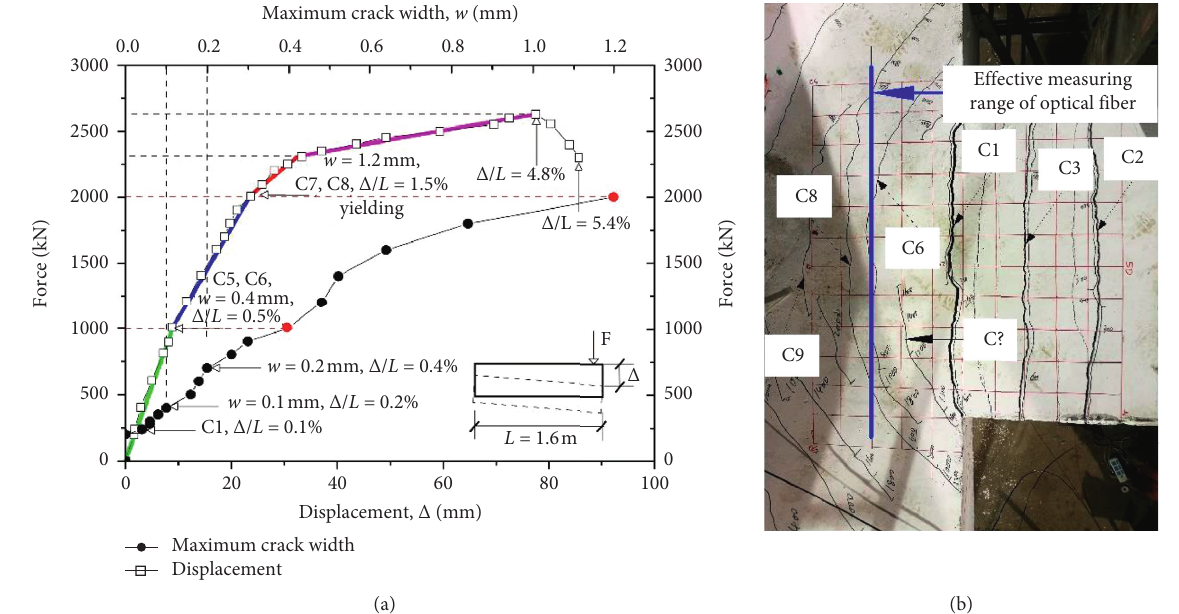
Figure 6: Force-displacement/maximum crack width and damage status at Δ / L � 5.4% (top